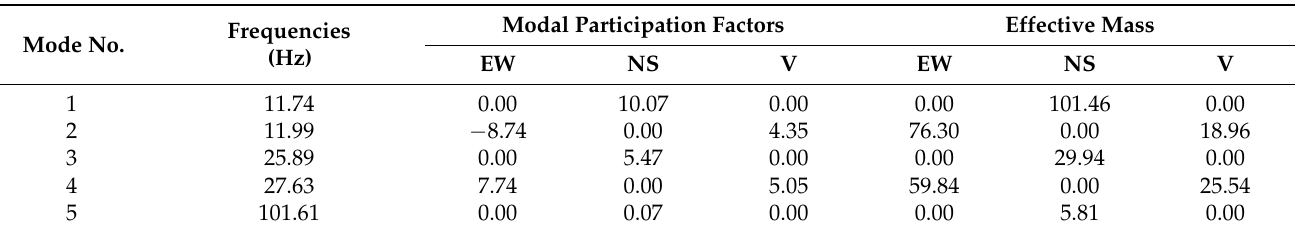
Table 2. Summaries of modal